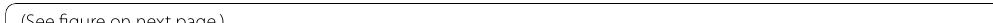
tetraterpenoids(See figure on next Fig. 1 The MVA pathway and MEP pathway for isoprenoids biosynthesis. The isoprenoid biosynthetic pathway can be grouped into the central carbon pathway, upstream isoprenoid pathway, and downstream isoprenoid pathway. PEP, phosphoenolpyruvate; HMG‑CoA, S‑3‑hydroxy‑3‑methylglutaryl‑CoA; DXP, 1‑deoxy‑ d ‑xylulose 5‑phosphate; MEP, 2‑C‑methyl‑ d ‑erythritol 4‑phosphate; CDP‑ME, 4‑(cytidine 5 ʹ ‑d iphospho)‑2‑C‑methyl‑ d ‑erythritol; CDP‑ME2P, 2‑phospho‑4‑(cytidine 5 ʹ ‑diphospho)‑2‑C‑methyl‑ d ‑erythritol; MEcPP, 2‑C‑methyl‑ d ‑erythritol 2,4‑cyclodiphosphate; HMBPP, 1‑hydroxy‑2‑methyl‑2‑butenyl 4‑diphosphate; IPP, isopentenyl diphosphate; DMAPP, dimethylallyl diphosphate; GPP, geranyl pyrophosphate; NPP, neryl pyrophosphate; FPP, farnesyl pyrophosphate; GGPP, geranylgeranyl pyrophosphate; CCP, central carbon pathway; C5, hemiterpenoids; C10, monoterpenoids; C15, sesquiterpenoids; C20, diterpenoids; C30, triterpenoids; C40,